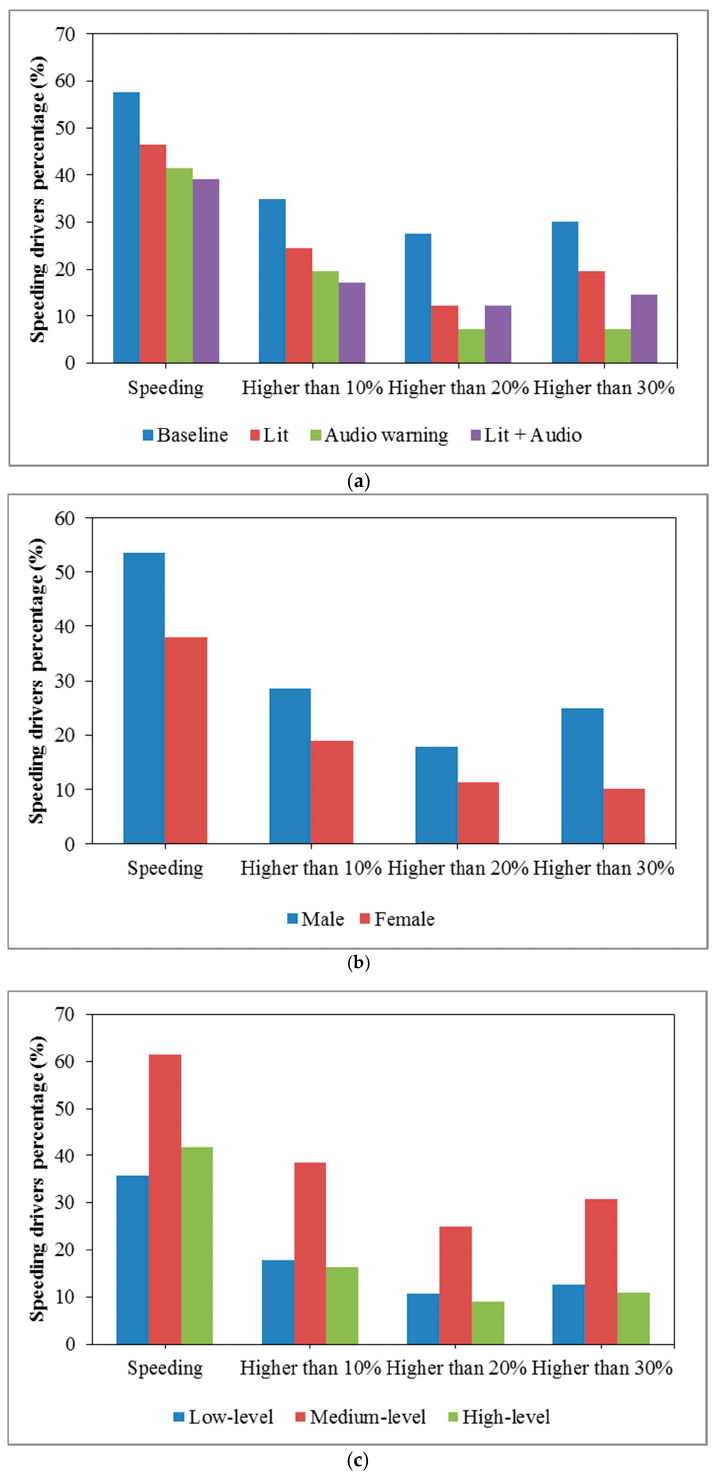
Figure 3. Speeding ratio distributions in terms of scenario, gender and driving experience. ( a ) Countermeasures; ( b ) gender; ( c ) driving experience. ( a ) Countermeasures; ( b ) gender; ( c ) driving